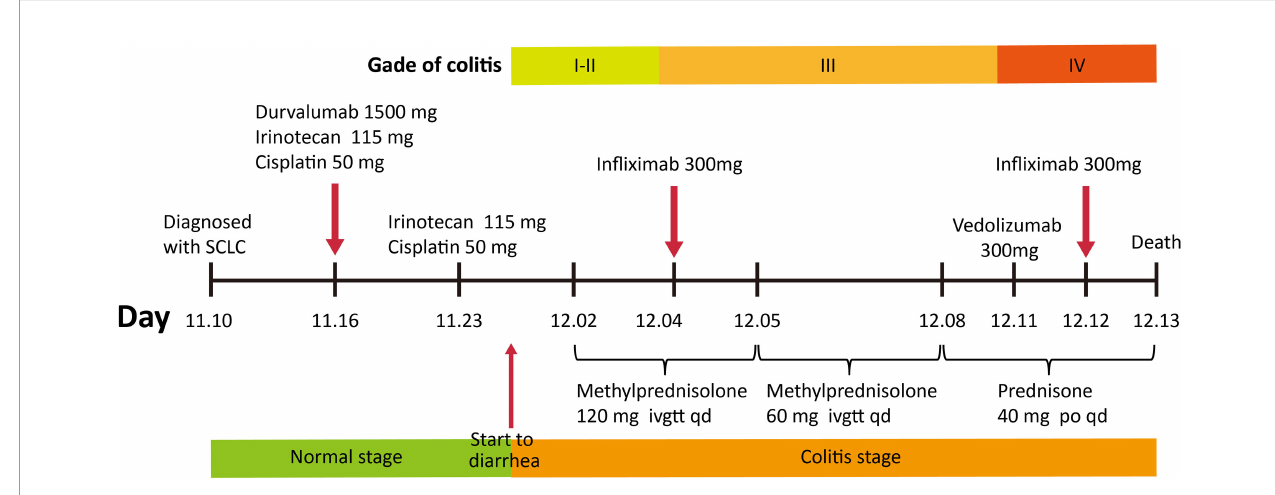
FIGURE 3 | Timeline of medications administered to the patient. SCLC, small cell lung cancer.